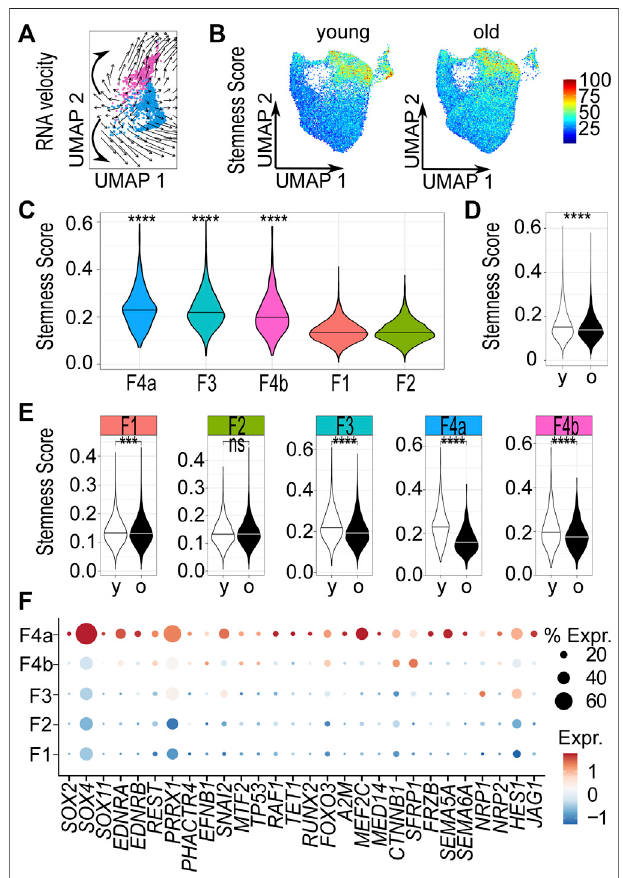
FIGURE4| Thedermalsheathpopulationlikelycontainsprogenitorcells thatarelostuponaging. (A) RNAvelocityanalysisofmesenchymalpopulation 4, computed arrows indicating the extrapolated future states of the cells, bold hand-drawn arrows indicating 2 cell fates. (B) Stemness score of each cell in Uniform Manifold Approximation and Projection (UMAP) plots youngvs. old. Violin plots ofstemnessscore of (C) young populations, (D) youngvs. old fi broblasts and (E) young vs. old populations. *** p < 0.001, **** p < 0.0001 (unpaired Wilcoxon rank sum tests). (F) Dot plot of the expression of genes accountingfor “ stemness ” geneontology terms by fi broblast populations. F1- 4b Fibroblast populations 1 – 4b, y young, o old. % expr. Percent expressed, expr. average